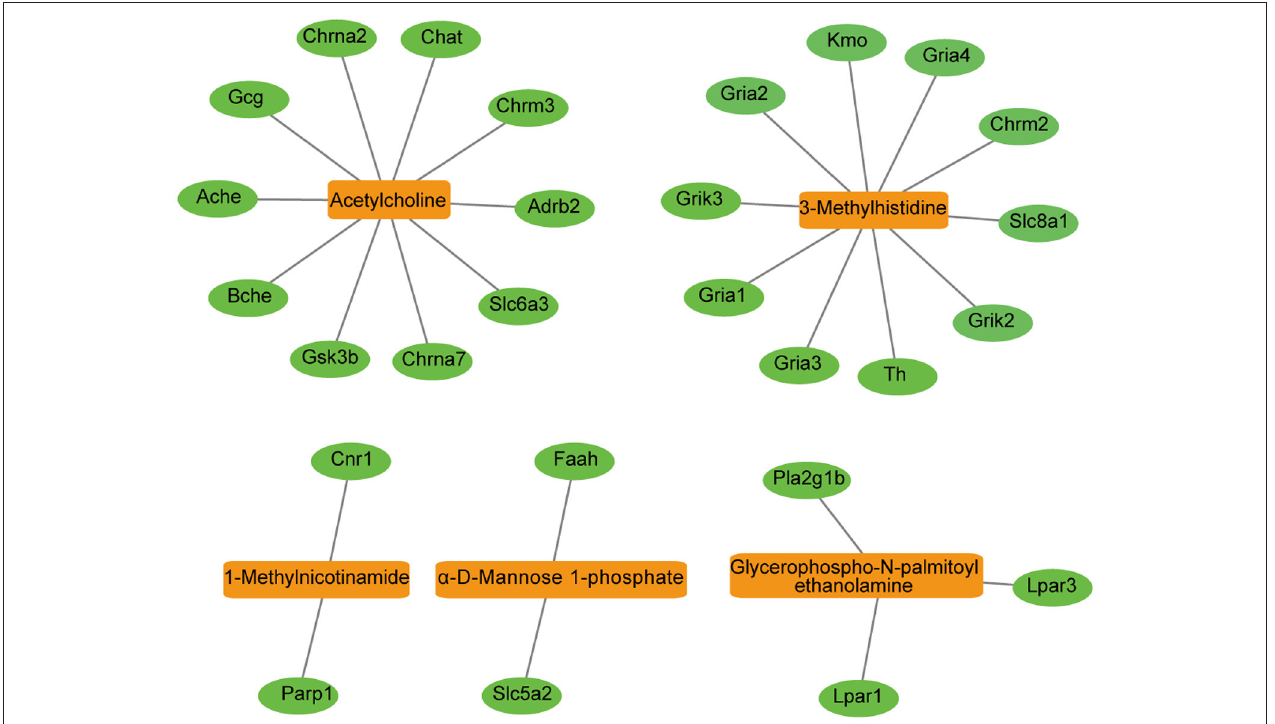
FIGURE 5 | Metabolite-protein network of the PFC visualized using the Cytoscape tool. The network was established with the nodes of metabolite compounds (orange rectangles) and protein enzymes (green ovals).